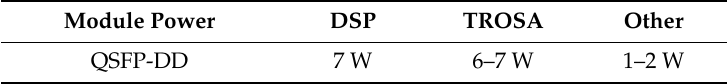
Table 1. Coherent digital signal processing (DSP) power consumption evolution. CMOS: complementary metal-oxide-semiconductor.